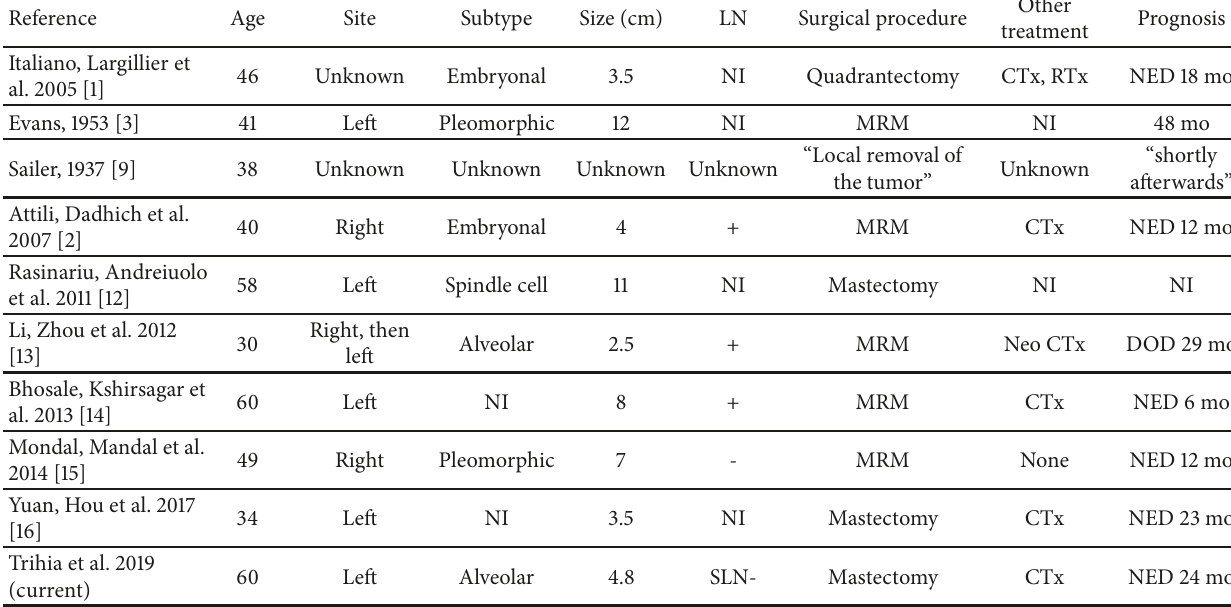
Table 1: Cases of primary RMS of the breast in adults: a summary of clinical